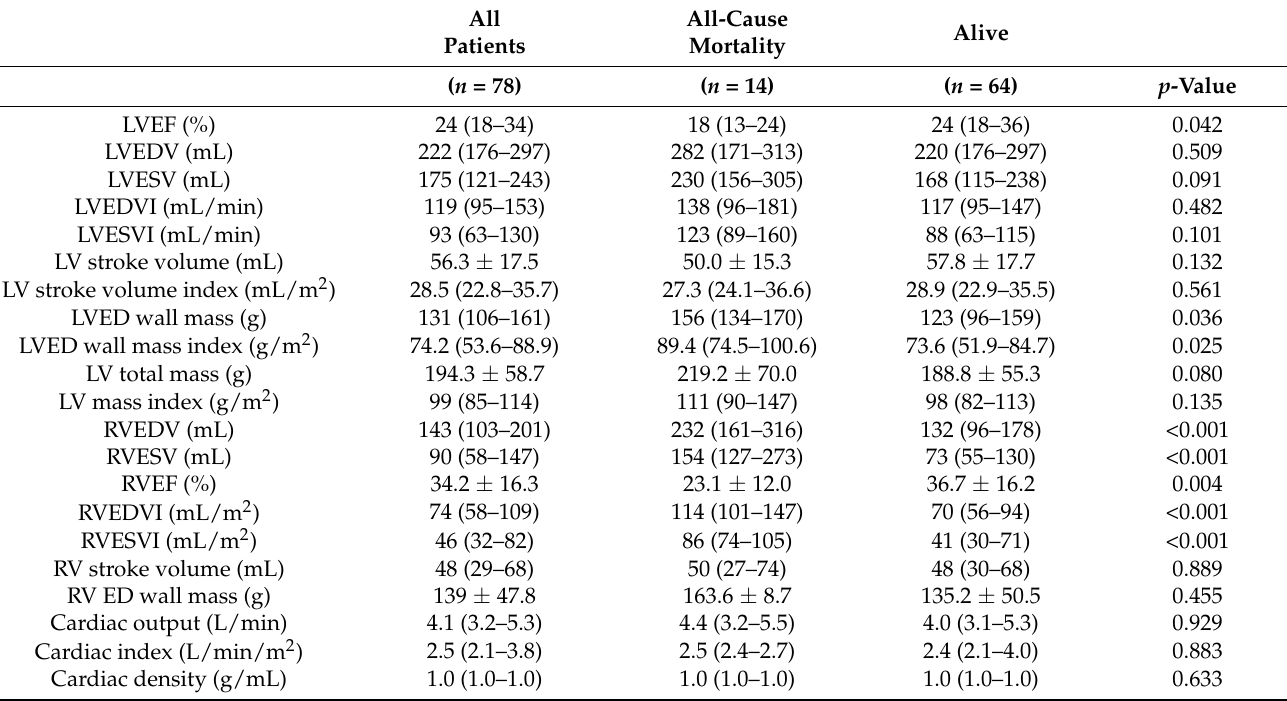
Table 2. Baseline cardiovascular magnetic resonance imaging parameters stratified according to all-cause mortality.